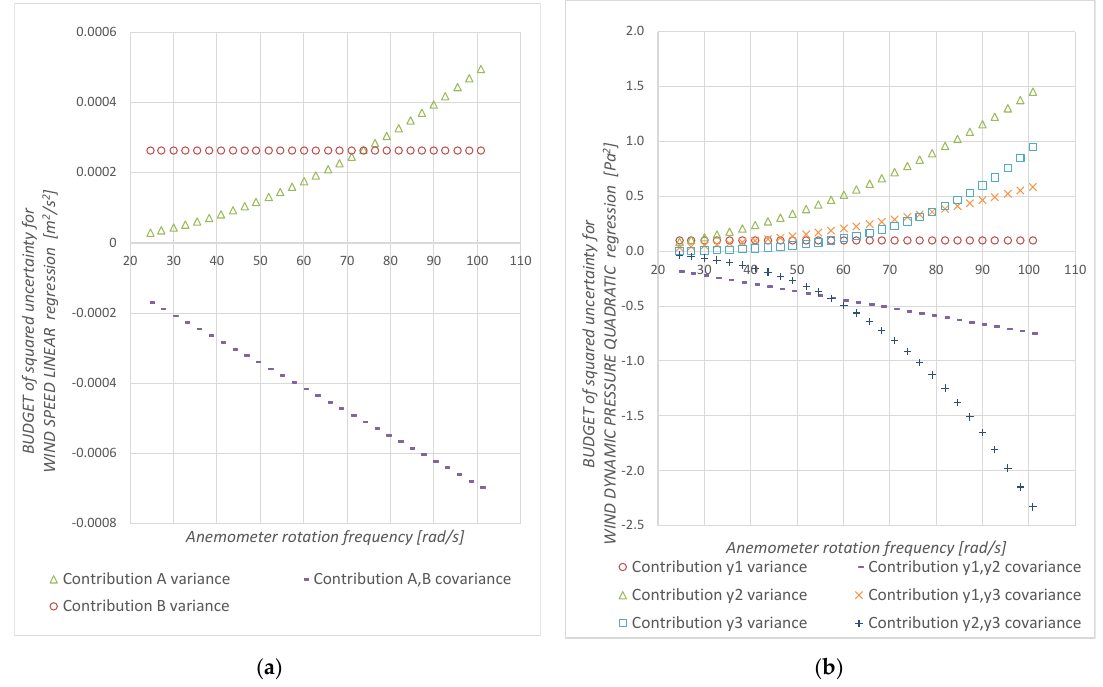
Figure 6. Regression uncertainty budget. ( a ) Linear regression (AS-Cup anemometer measurement method), ( b ) quadratic regression (DYP-Cup anemometer measurement method).